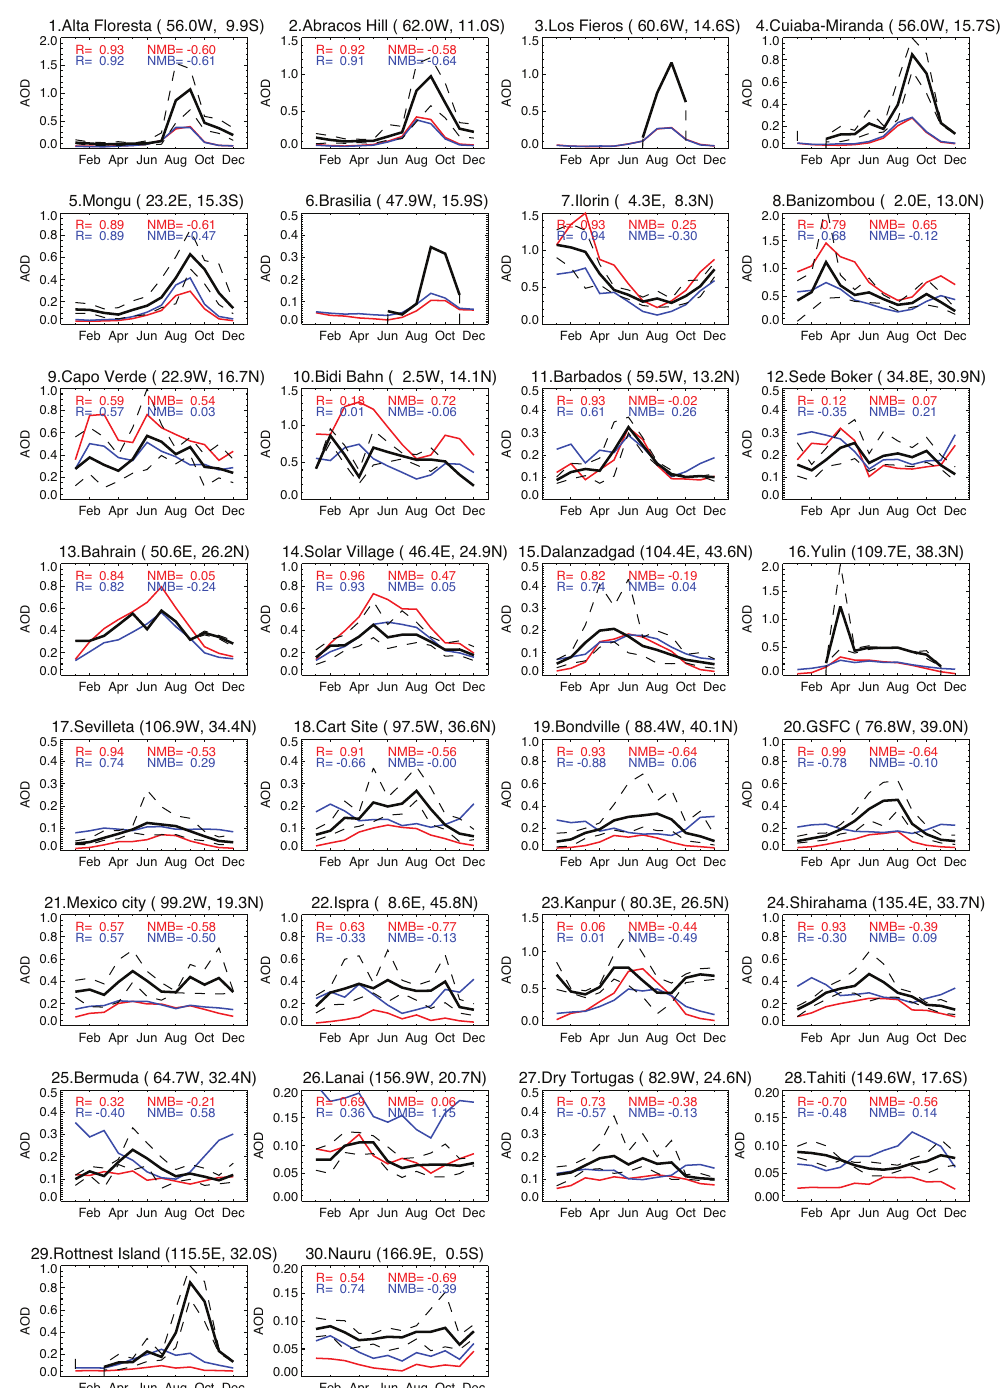
Figure 18. Comparisons of monthly averaged model AOD (red for ModelE2-TOMAS and blue for ModelE2-OMA) and AERONET AOD (black solid line). Correlation ( R ) and normalized mean bias (nmb) are provided only when the observation is available for 12 months.